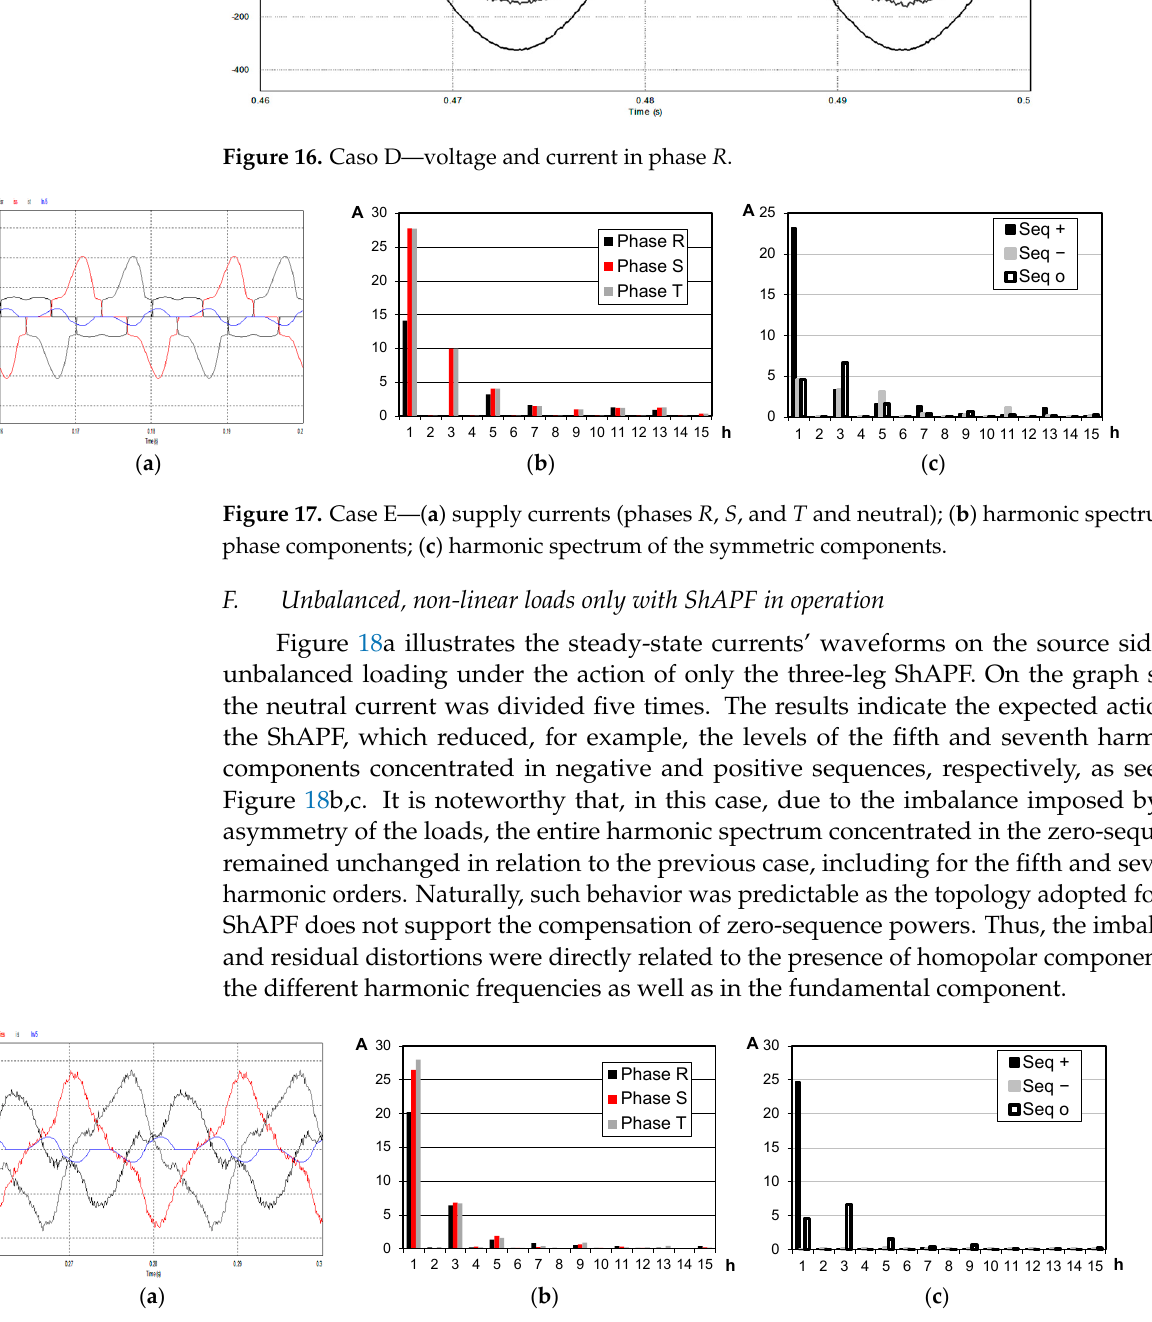
Figure 18. Case F - ( a ) supply currents (phases R , S , and T , and neutral); ( b ) harmonic spectrum of phase components; ( c ) harmonic spectrum of the symmetric components.